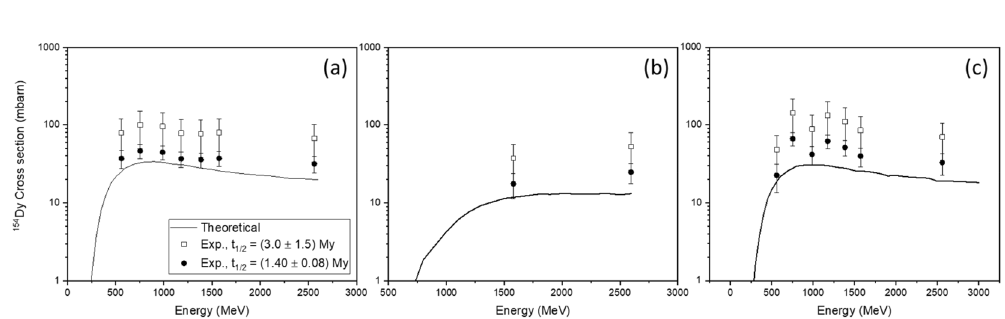
Figure 4. Excitation functions for the production of 154 Dy in proton irradiated Ta ( a ), Pb ( b ), and W ( c ) targets. Solid lines: theoretical values obtained with INCL + + and ABLA 07 codes; filled dots: experimental values using t 1/2 = (1.40 ± 0.08) My; open squares: experimental values using t 1/2 = (3.0 ± 1.5)